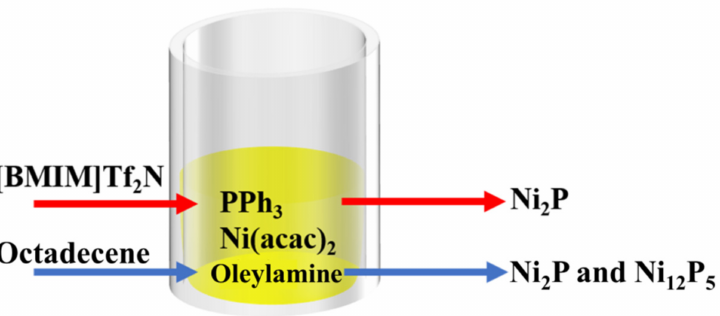
Figure 2. Pure Ni 2 P and the mixture of Ni 2 P/Ni 12 P 5 obtained using [BMIM]Tf 2 N or octadecene as medium, respectively